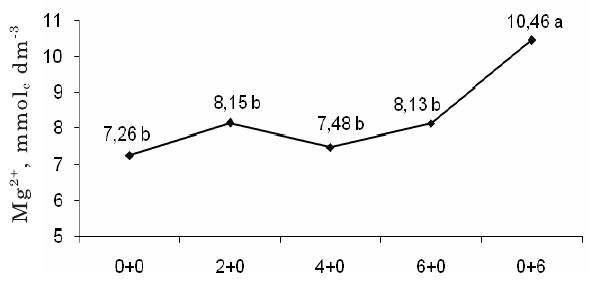
Figura 3. Teores médios de Mg 2+ no solo para os tratamentos. Valores acompanhados de uma mesma letra não diferem estatisticamente entre si pelo teste de Tukey.